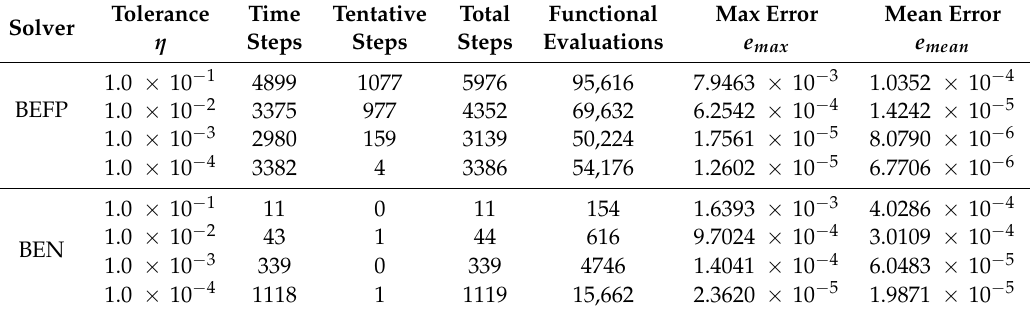
Table 5. Solution of MCDB equation for µ = 5 using the shifted Strang–Marchuk splitting method.